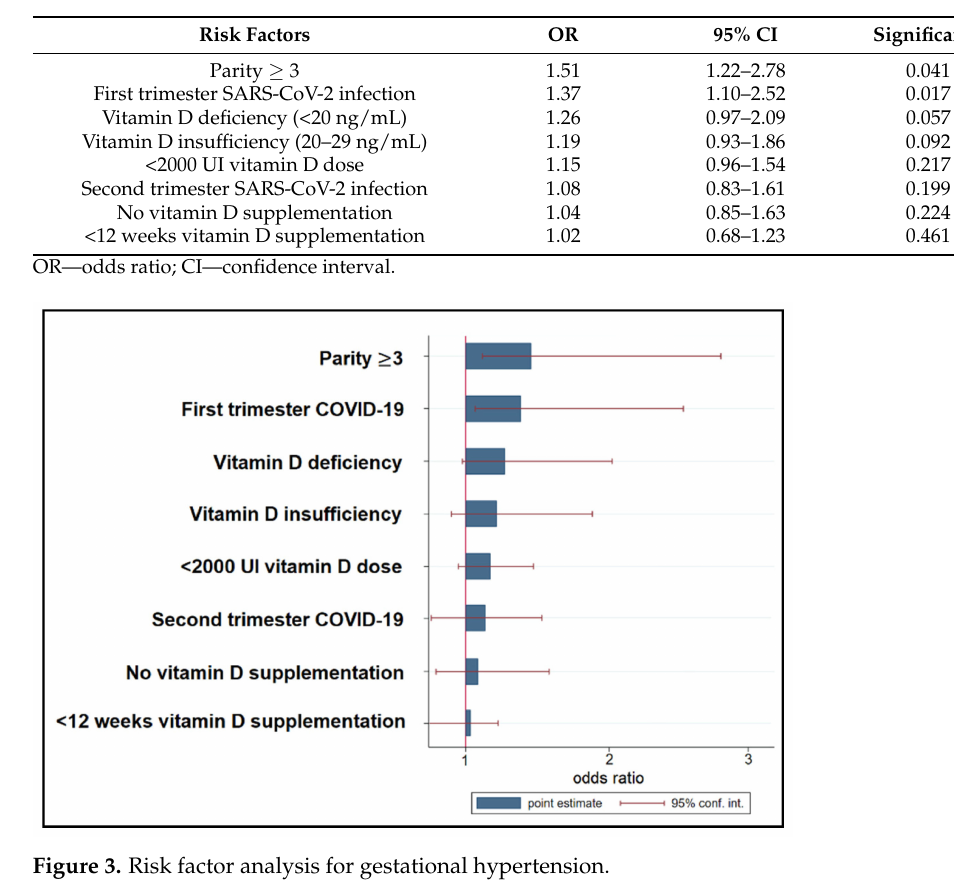
Figure 3. Risk factor analysis for gestational